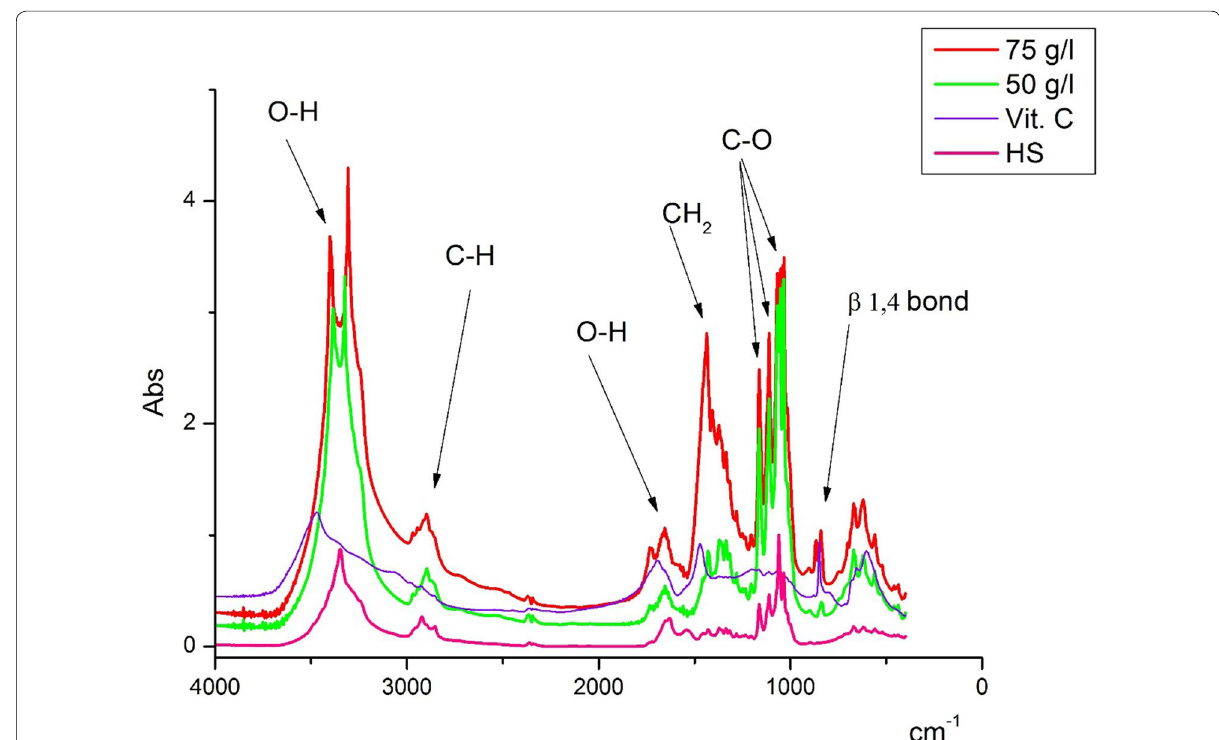
Fig. 3 FTIR spectra of bacterial cellulose obtained in static and dynamic condition of cultivation on various